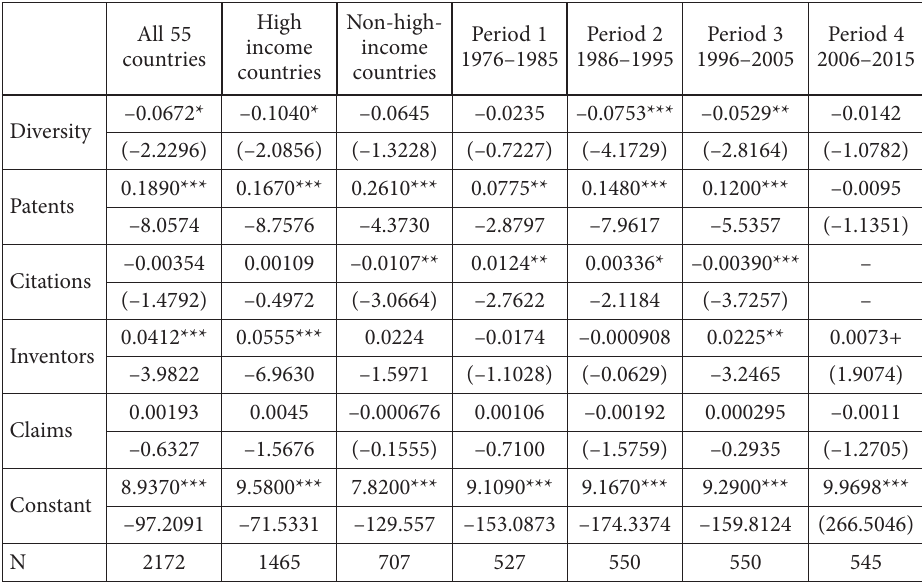
Table 4. OLS regression